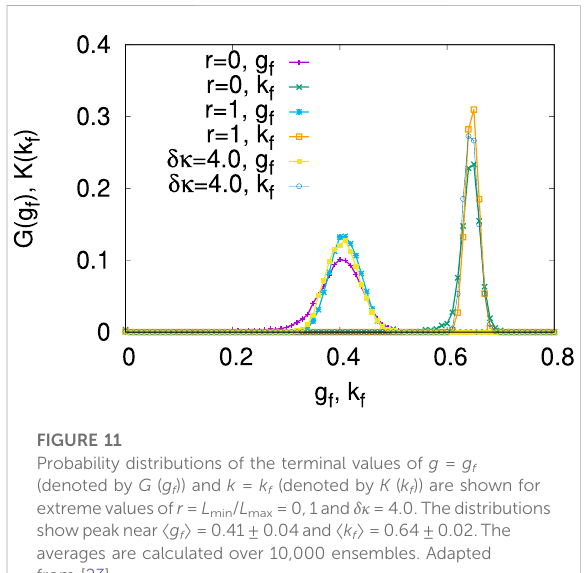
FIGURE 11 Probability distributions of the terminal values of g = g f (denoted by G ( g f )) and k = k f (denoted by K ( k f )) are shown for extremevaluesof r = L min / L max =0,1and δκ =4.0.Thedistributions showpeaknear 〈 g f 〉 =0.41±0.04and 〈 k f 〉 =0.64±0.02.The averages are calculated over 10,000 ensembles. Adapted from